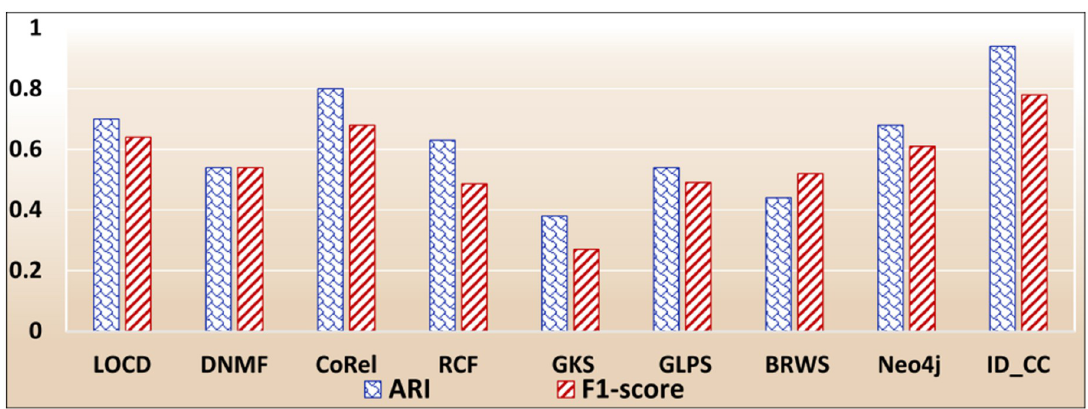
Fig 31. The overall average ARI and F1-score of each method for detecting the Facebook Social circles cross-communities.